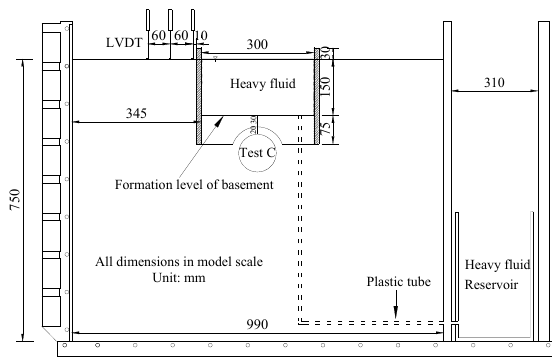
Figure 1. Layout of the proposed centrifuge model test [7] .